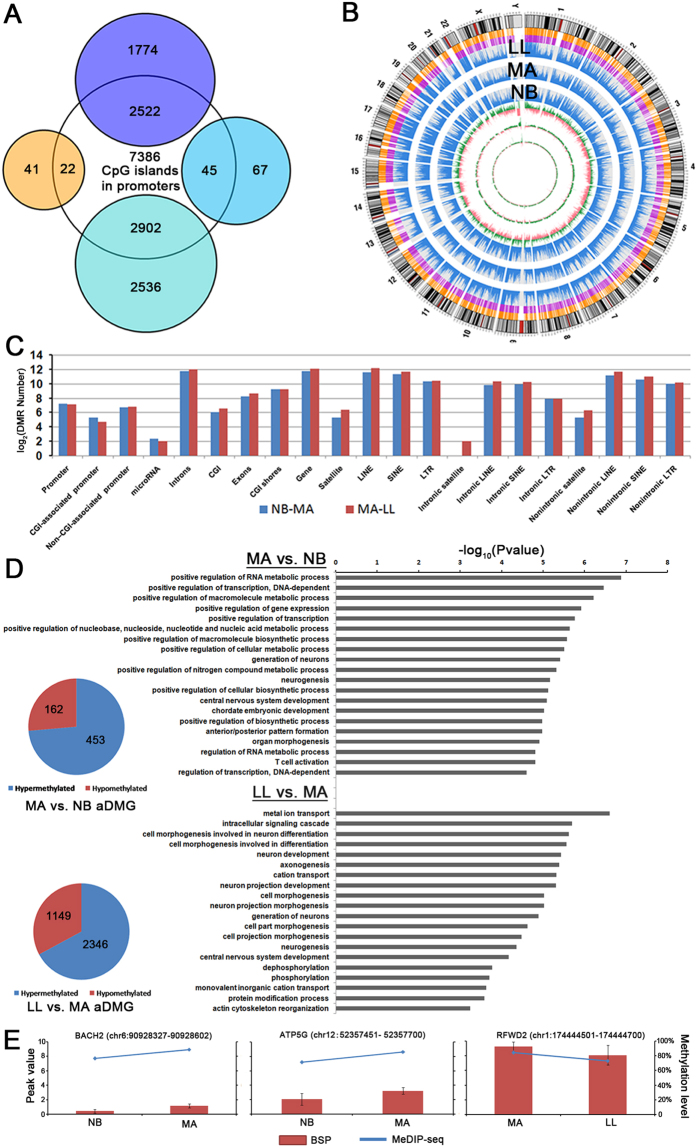
Age-specific differentially methylated regions (aDMRs) and related genes (aDMGs).(A) Venn diagram of the distribution of genes corresponding to the blue, turquoise, royal blue and dark orange modules based on whether they possess CpG islands in promoters. (B) Circos representation of genome-wide DNA methylation levels in the NB, MA, and LL groups. From outer to inner, this graph displays chromosomal karyotypes; promoters; CpG islands; read distributions of the LL, MA, NB groups in 100-kb segments; and differential DMR distributions of NB vs MA, MA vs LL and NB vs LL. Green represents log2 ratios > 0, and red represents log2 ratios < 0. (C) aDMR distribution among different genomic sequences. (D) aDMG distribution according to the direction of the DNA methylation change, and GO enrichment analysis of these aDMGs between MA and NB individuals and between LL and MA individuals. (E) The patterns of change in promoter methylation of three aDMGs (BACH2, ATP5G and RFWD2) confirmed by BSP are consistent with the results from MeDIP-seq.